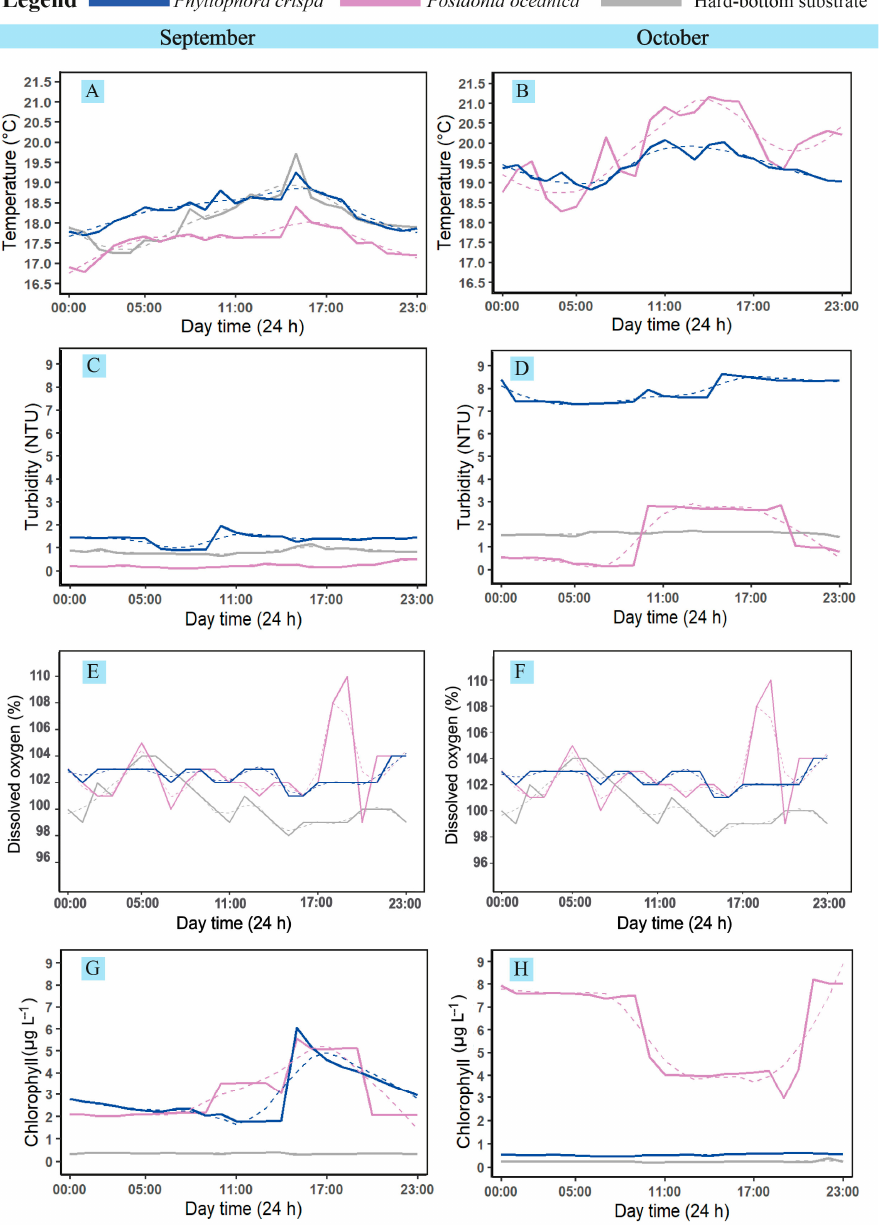
Figure 3. Comparison of temperature ( A , B ), turbidity ( C , D ), dissolved oxygen ( E , F ), and chlorophyll ( G , H ) in Phyllophora crispa mats (blue line), Posidonia oceanica meadows (pink line), and hard-bottom habitats (gray line), during September (left) and October (right). Probes were placed for at least 24 h with n = 8 for P. crispa , n = 6 for P. oceanica , and n = 5 for hard-bottom habitats in September 2019 and n = 3 for P. crispa , n = 7 for P. oceanica , and n = 2 for hard-bottom habitats in October 2019. The continuous lines are the daily mean values; the dotted lines are the trend line of values. The temperature data for October ( B ) in the hard-bottom habitats are missing due to technical